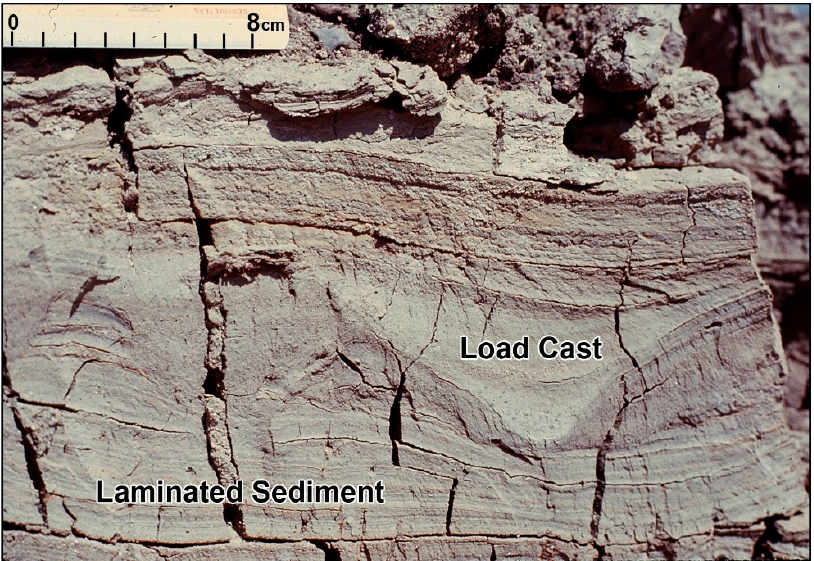
Figure 7. Load cast that formed in interbedded and laminated sediment of Van Norman Lake during the 1952 M 7.5 Kern County (California) earthquake [97].